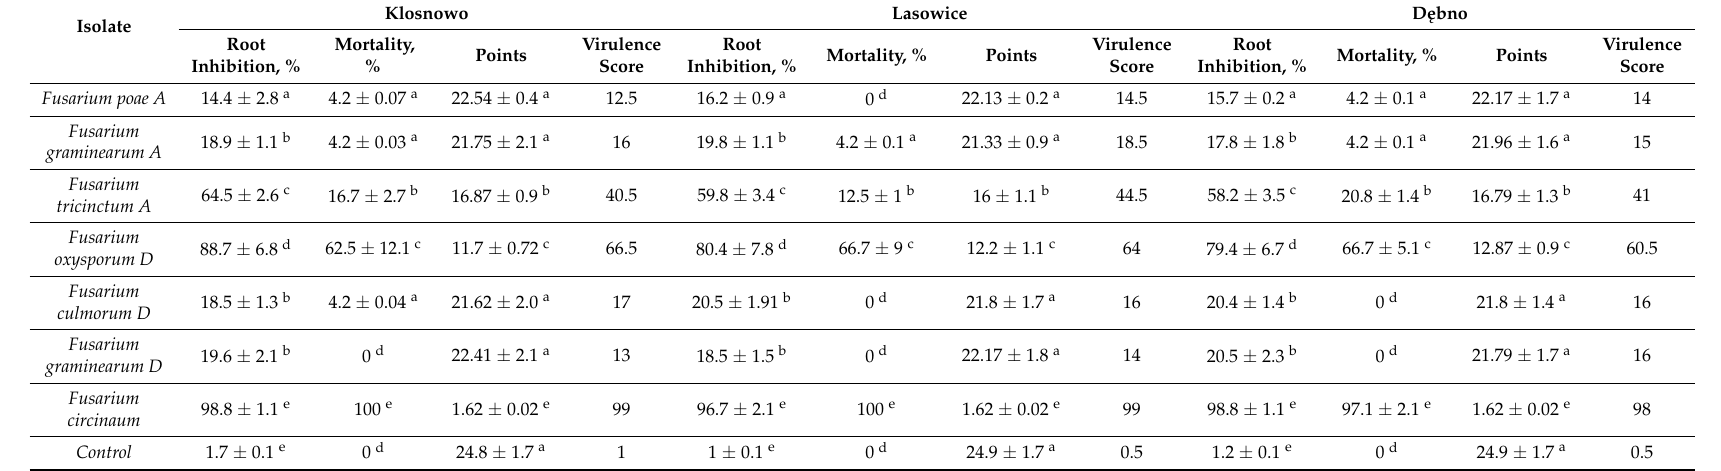
Table 3. Effects of different Fusarium isolates on Pinus sylvestris growth and root development.